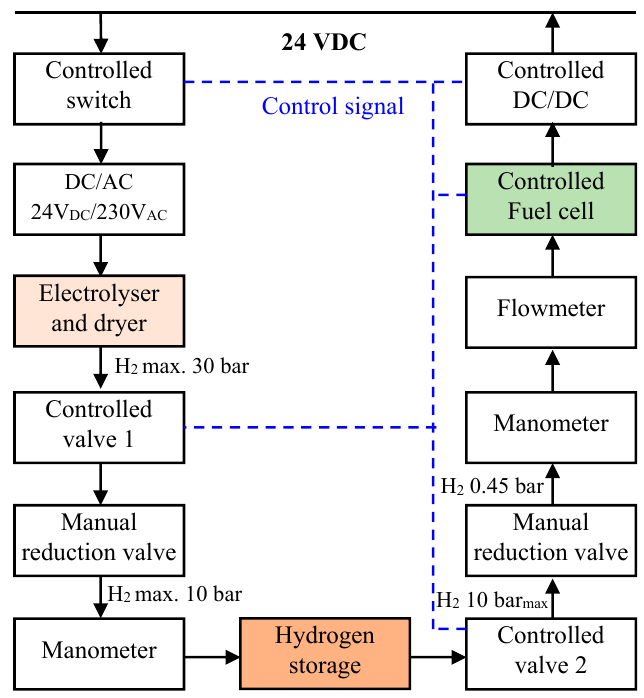
Figure 6. A block diagram of the hydrogen circuit.